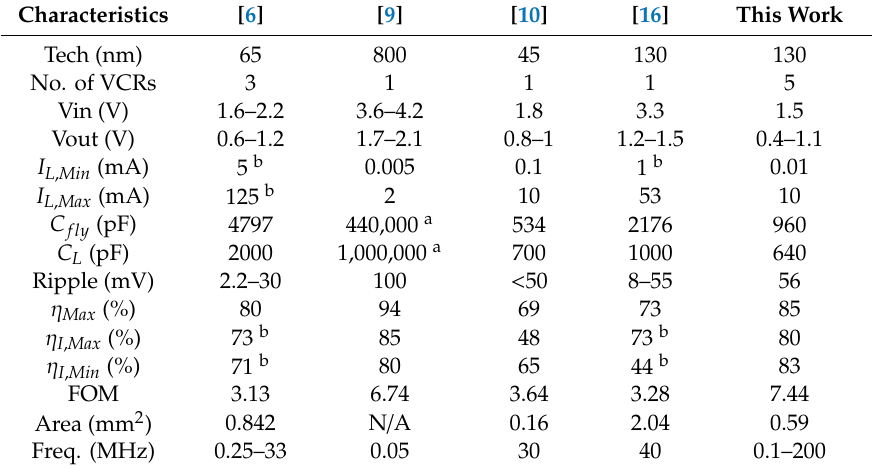
a O ff -chip Component. b Approximated values from